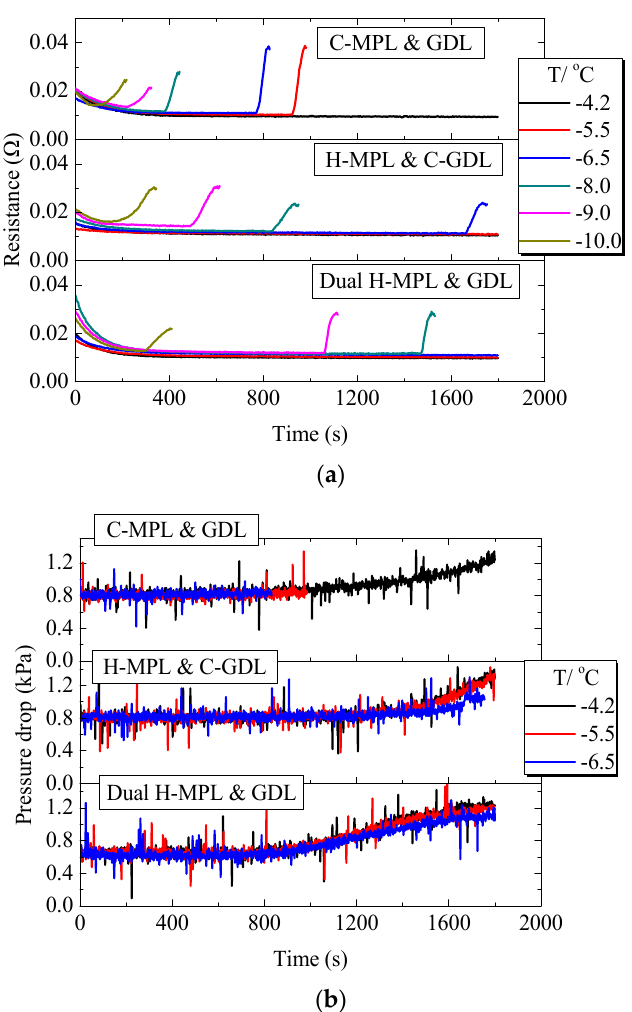
Figure 12. Low-temperature start performance of the PEMFC with different structures of MPL/GDL: ( a ) Variation in the ohmic resistance of the PEMFC; ( b ) Variation in the pressure drop in cathode gas channel.